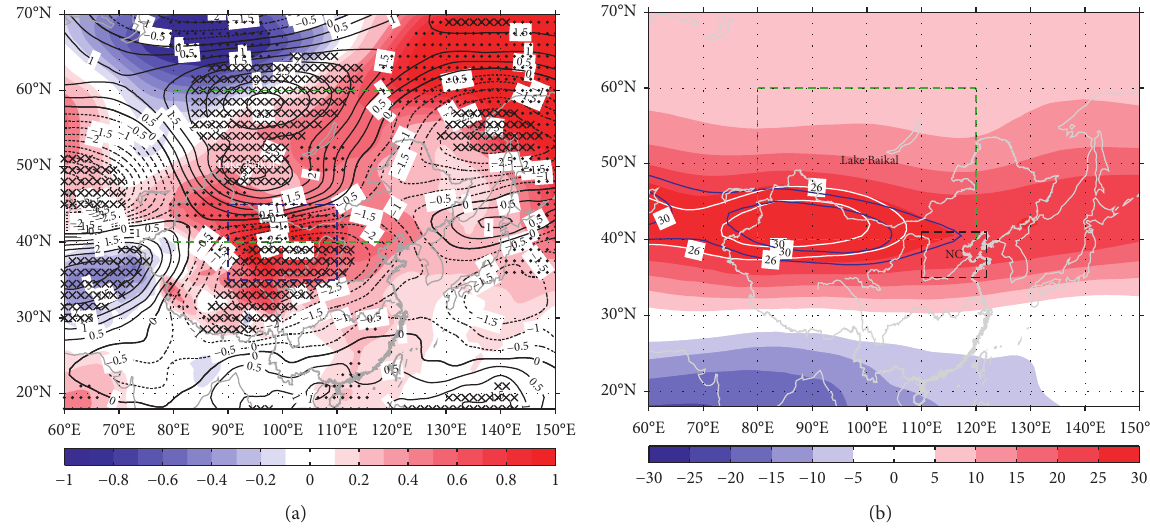
Figure 8: (a) Same as Figure 5 but for 200hPa zonal winds (contours, unit: m/s) and temperature (shading, unit: ° C). The difference of temperature in blue box with black dots is statistically significant at the 95% confidence level according to Student’s t -test. The difference of zonal winds with black cross is statistically significant at the 95% confidence level according to Student’s t -test. (b) 200hPa zonal winds (unit: m/s) in JA of 1979–1996 mean (black contours) and 1997–2016 mean (white contours). The shading is the climatic mean of 200hPa zonal winds during 1979–2016. The black box shows North China. The green box shows the region of Lake